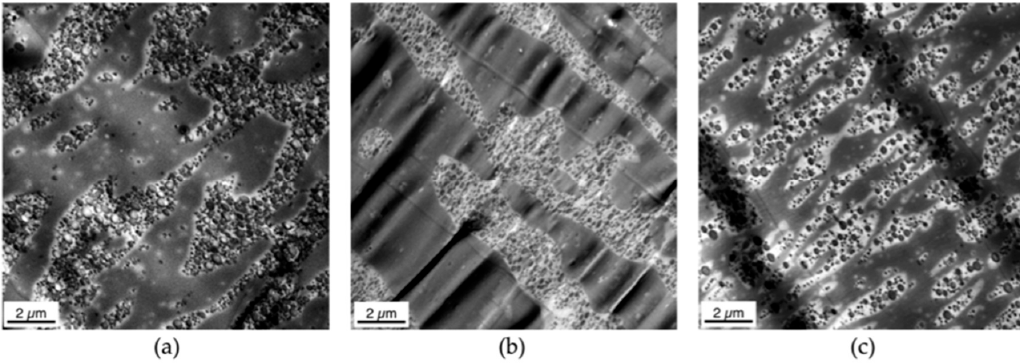
Figure 13. TEM micrographs of the core of specimens injection-molded from PC/ABS blends with ( a ) SAN low; ( b ) SAN medium; and ( c ) SAN high.